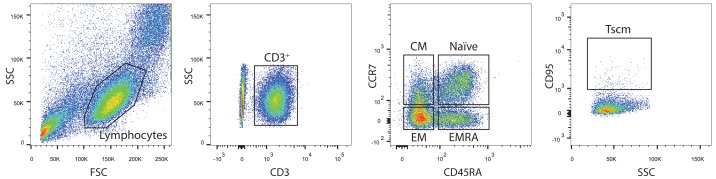
Gating strategy for memory subpopulations.Central memory (CM) cells were defined as CD3+CCR7+CD45RA-. Effector memory (EM) cells were CD3+CCR7-CD45RA-. Terminally differentiated effector memory (EMRA) cells were CD3+CCR7-CD45RA+. Stem-cell like memory (Tscm) cells were CD3+CCR7+CD45RA+CD95+.